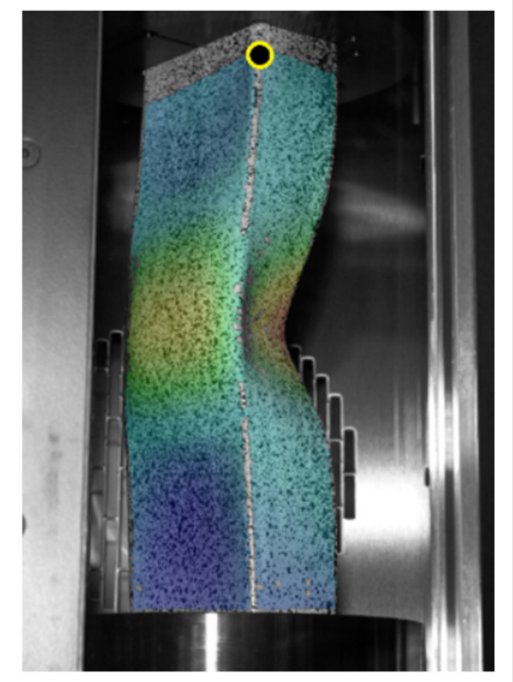
Figure 7. An exemplary registration point for force vs. shortening